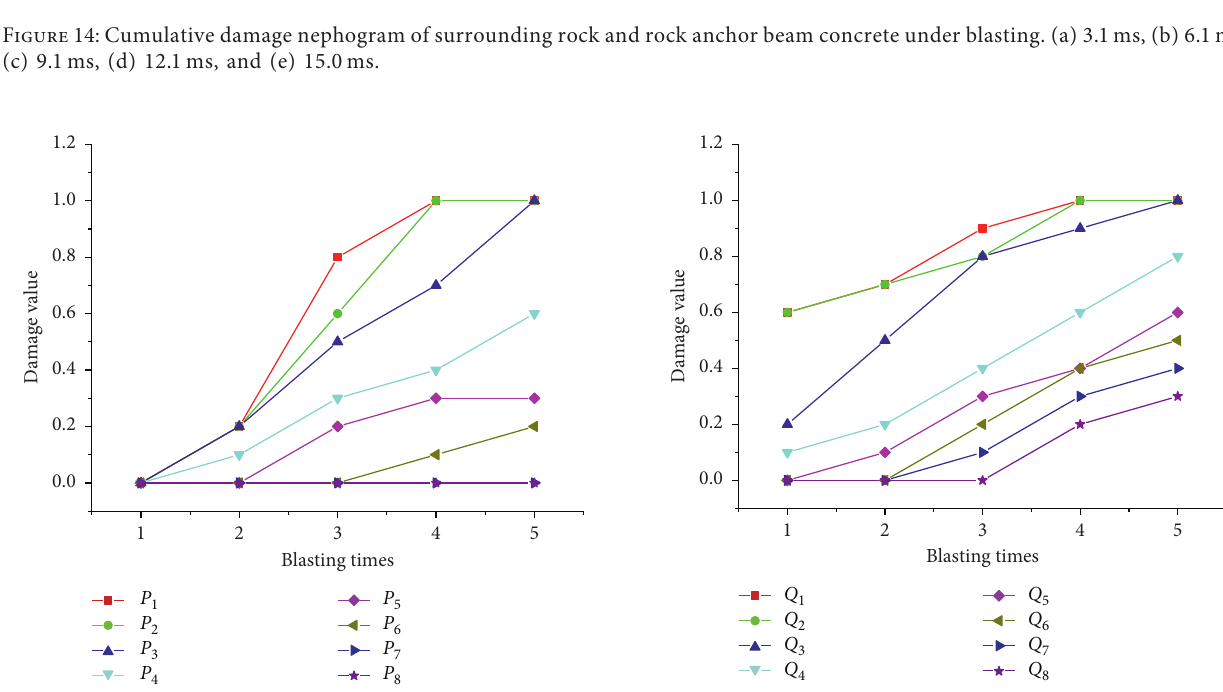
Figure 15: The curve of the relationship between cumulative damage of rock anchor beam monitoring points along the axis of powerhouse and blasting times.